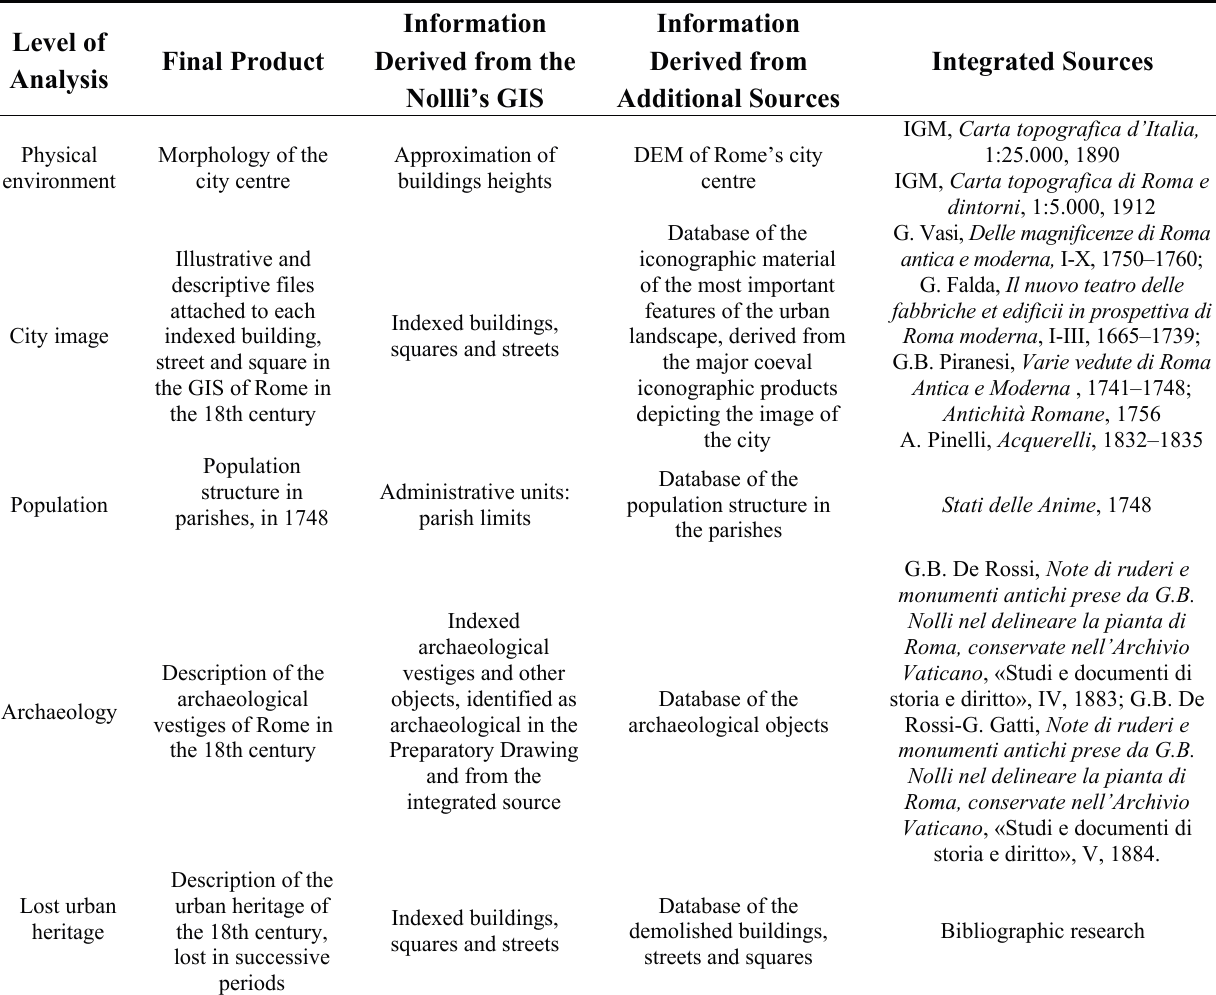
Table 1. Historical sources and their use in the Atlas of modern